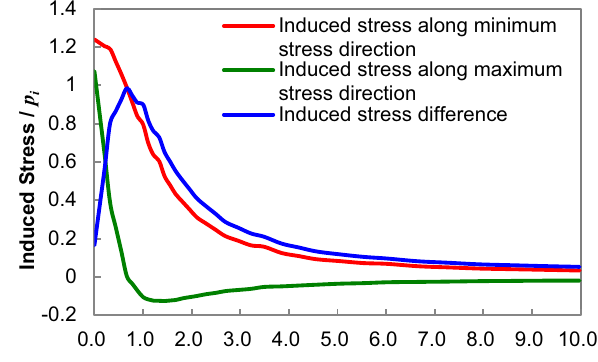
Fig. 5 Induced stress distribution around a fracture along the direc- tion of wellbore central axis